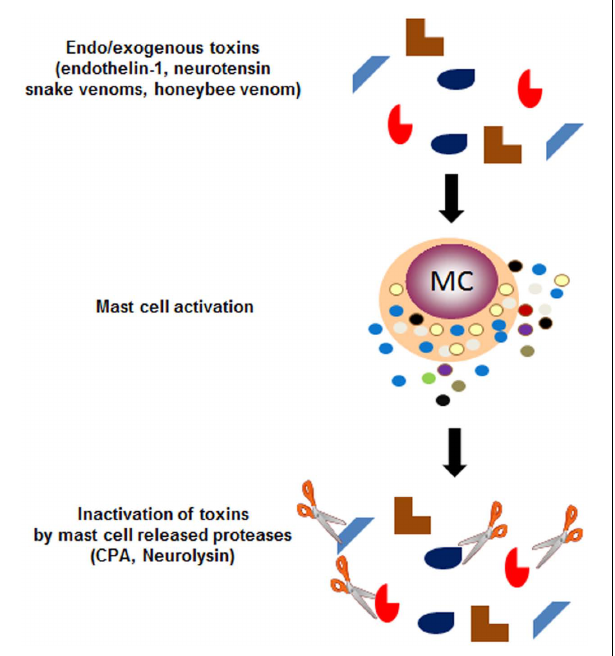
FIGURE 1 | Immediate hypersensitivity responses to inactivate endo- or exogenous venoms. While IgE-dependent hypersensitivity reactions have been known for long to initiate allergic responses, recent research has unveiled that this type of response can also be activated by certain endogenous or exogenous toxins, which cause the mast cells to release granule-stored proteases, which in a feed-back mechanism can inactivate these toxins through proteolytic cleavage.Thus endogenously produced highly active pharmacological peptides such as endothelin-1 and neurotensin can be cleaved with mast cell-released carboxypeptidase A and neurolysin, respectively. Similarly certain snake venoms such as sarafotoxins, which bear homology to endothelin-1 can also be cleaved by CPA. Interestingly, while honeybee venom has been shown in some cases to cause IgE-dependent deadly anaphylactic reactions, mast cell released products also serve to inactivate this venom and limit its